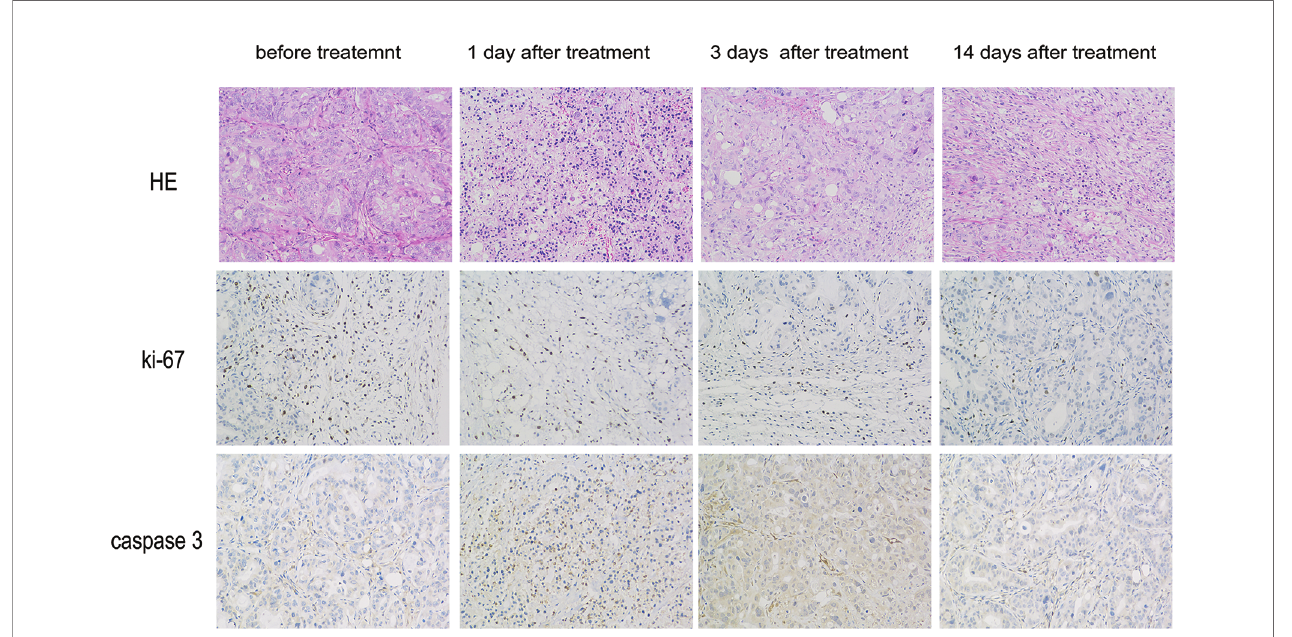
FIGURE 3 | Histopathology of pancreatic cancers after nsPEFs treatment. 0, 1, 3, and 14 days after treatment, the mice were euthanized and samples were harvested. Tumor cell structure and nuclear changes were analyzed by hematoxylin and eosin (H&E) staining. Samples were also prepared for immunohistochemistry with antibodies to Ki-67 and caspase-3. Magni fi cation,